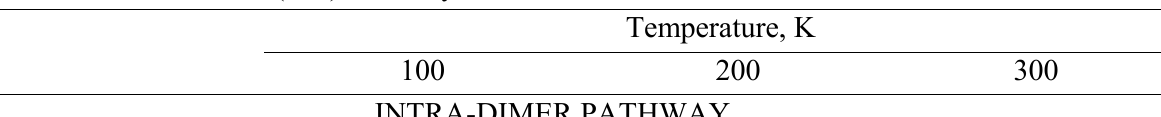
Table 3. Rate constants (in s -1 ) and kinetic isotope effects (KIE) k(NH of dissociation of the NH